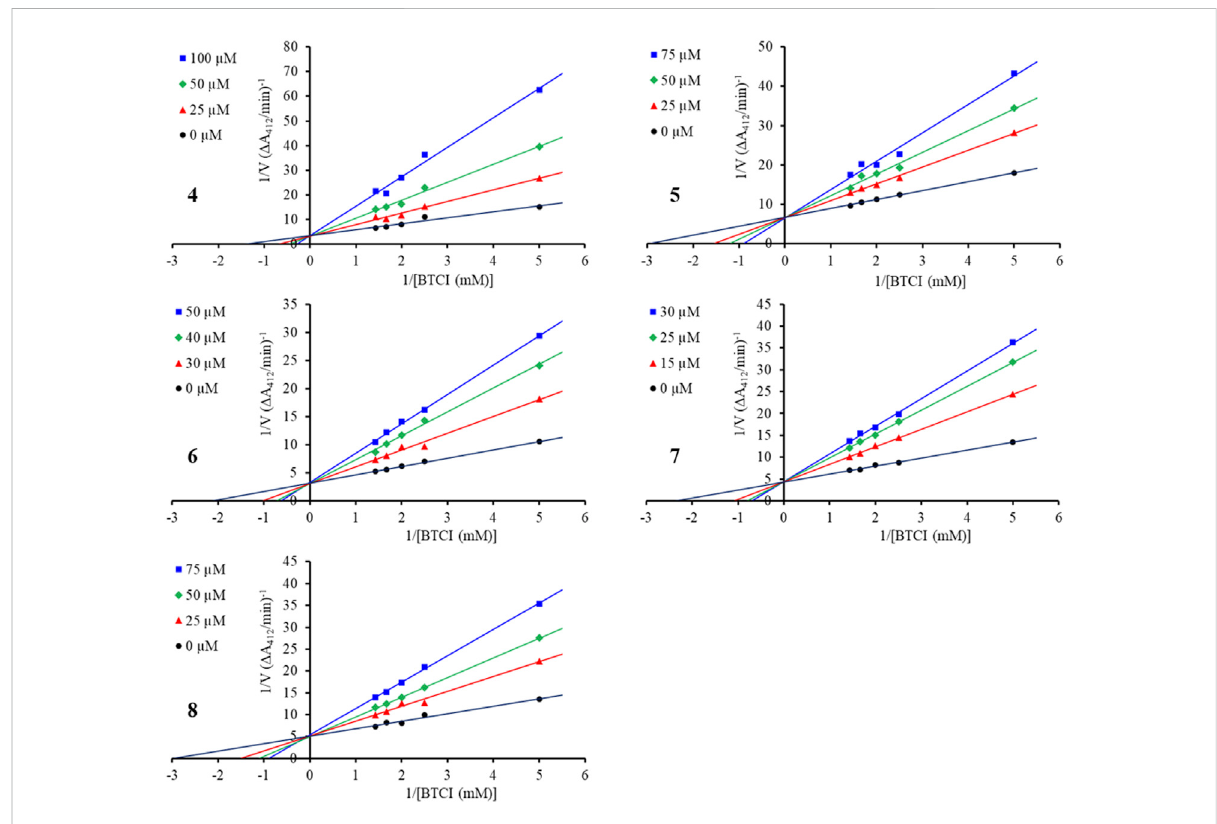
FIGURE 4 Lineweaver — Burk plot for BChE inhibition by compounds 4 – 8